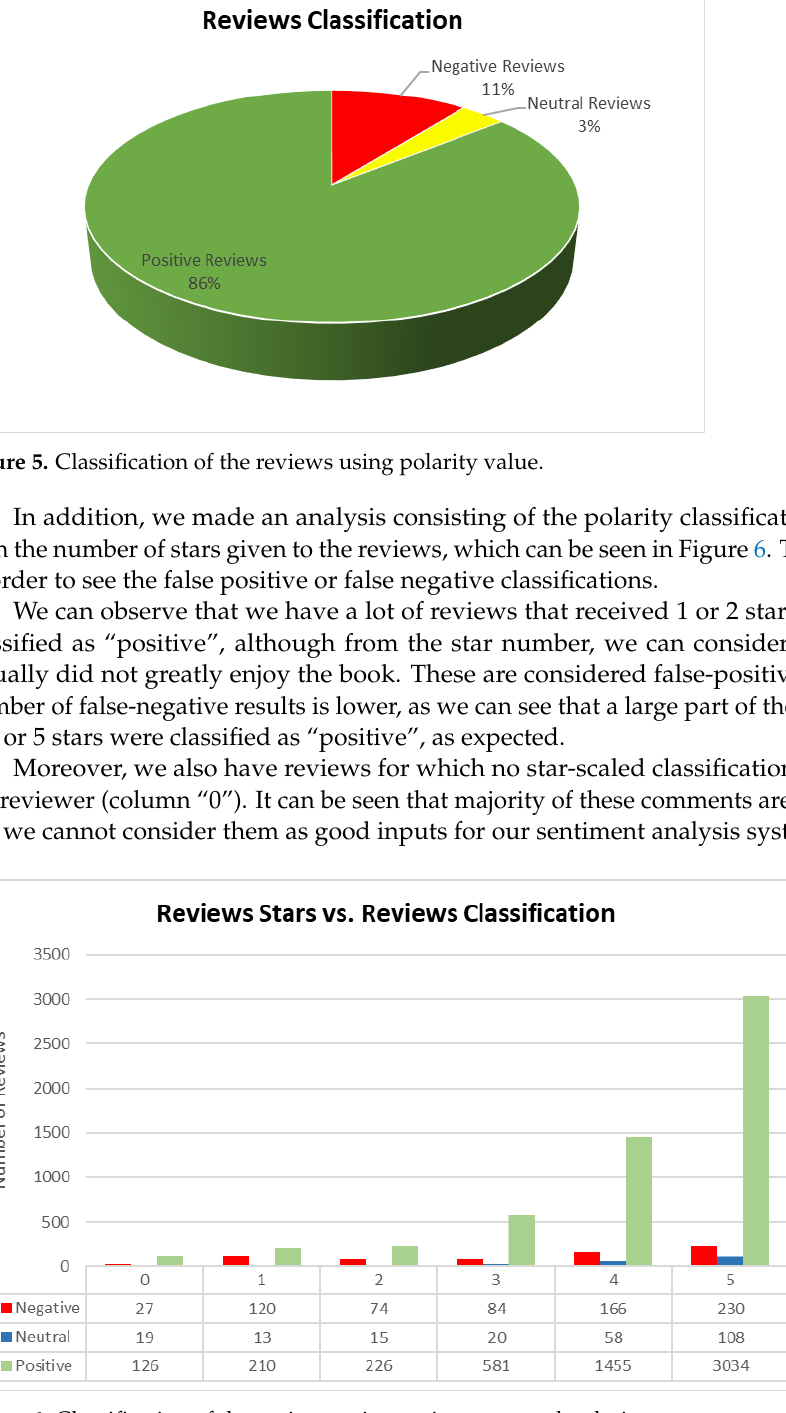
Figure 6. Classification of the reviews using review stars and